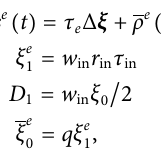
Frontiers in Applied Mathematics and Statistics |